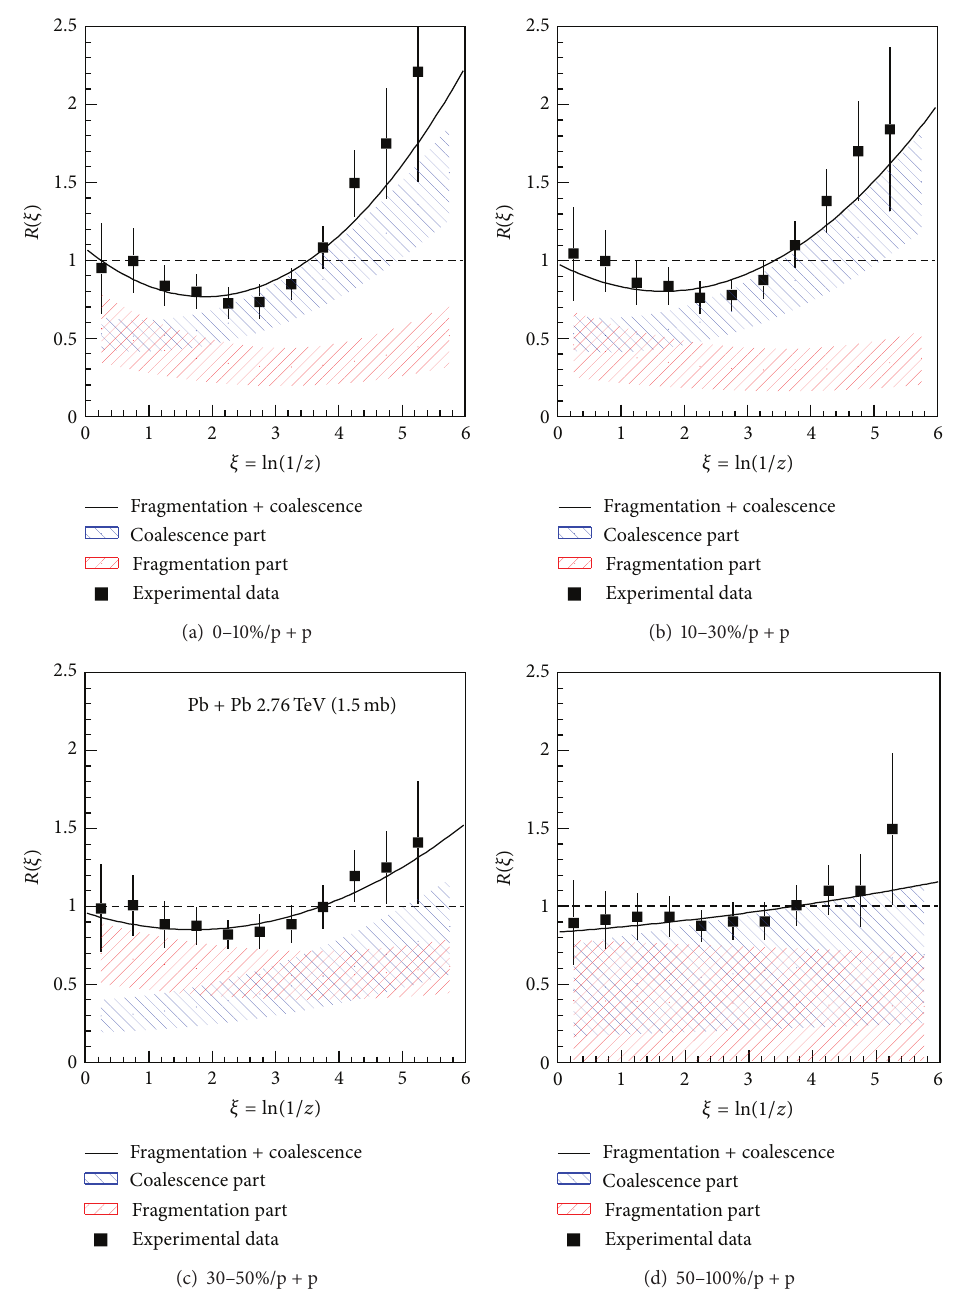
Figure 7: The jet fragmentation function ratios of four centrality bins in Pb + Pb collisions to p + p collisions. The solid curves show two- component (fragmentation + coalescence) fitting functions, while the two kinds of hatched areas give the fragmentation and coalescence contribution parts, that is, 𝜆 𝑓 𝑅 𝑓 (𝜉) and 𝜆 𝑐 𝑅 𝑐 (𝜉) , for the jet fragmentation function ratios measured by the CMS experiment